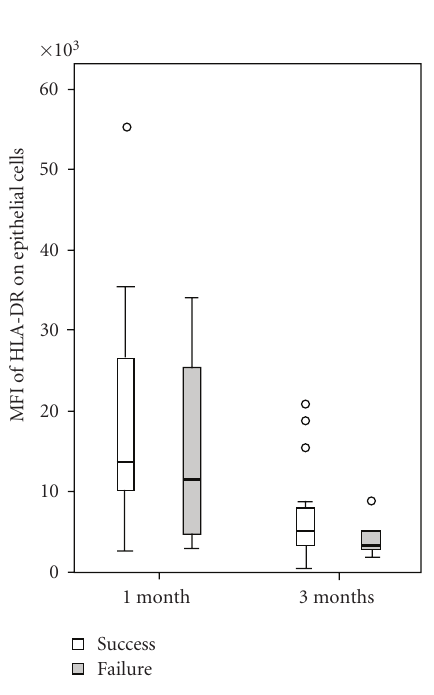
Figure 5: Box plot of expression of HLA-DR on conjunctival epithelial cells 1 month and 3 months after surgery in eyes with successful and failed trabeculectomy ( P = .